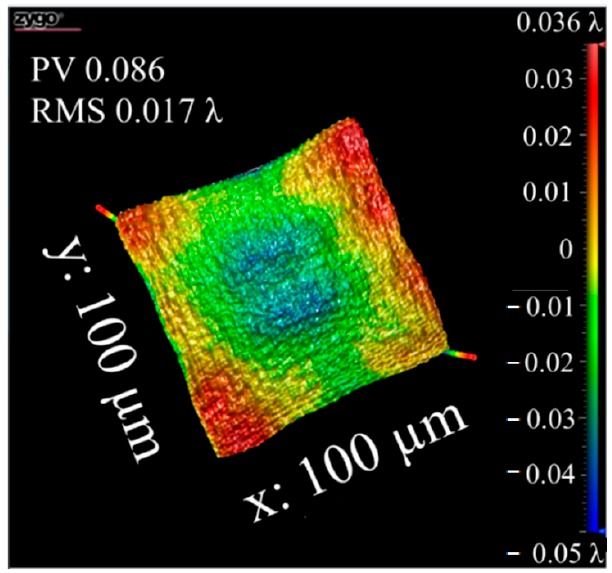
Figure 3. Patterns of roughness and flatness of the ZGP elements, registered by ZYGO interferometer.